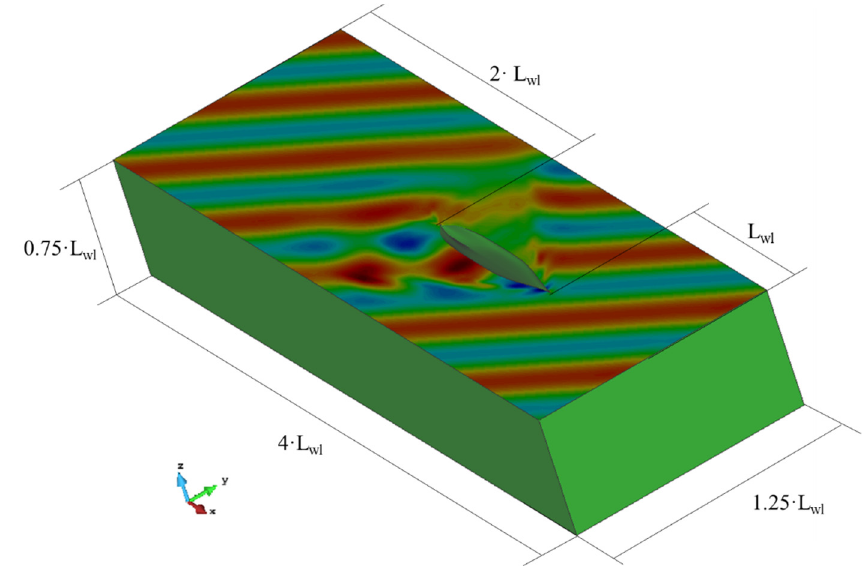
Figure 6. Layout of computational domain used to compute added resistance in waves. Source: Own elaboration.